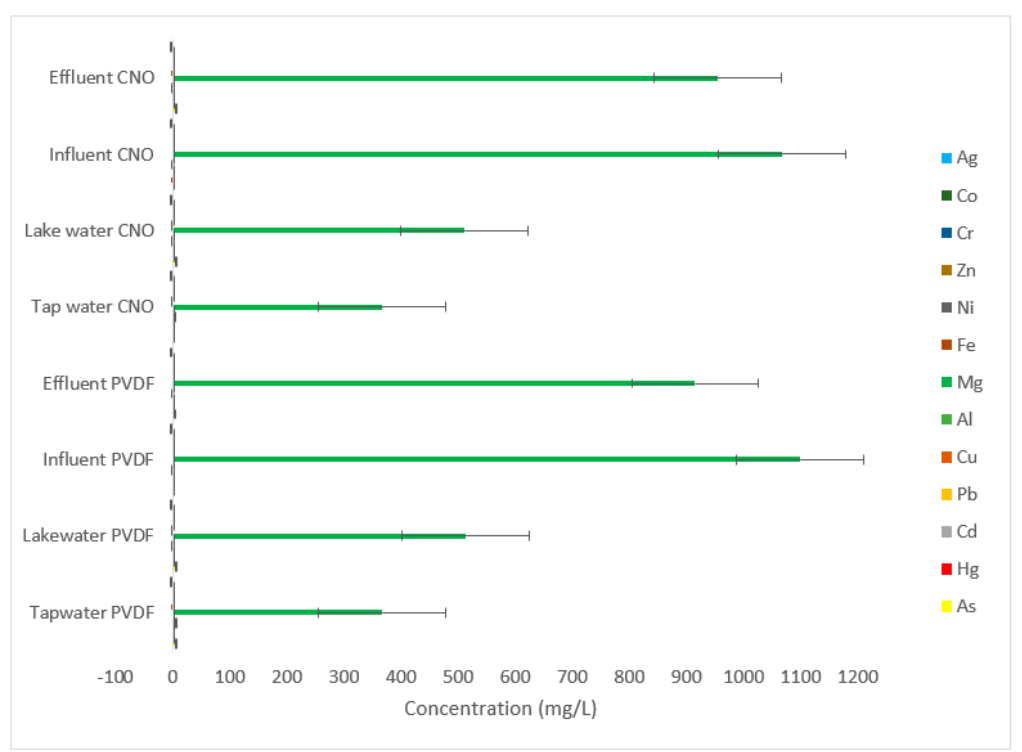
Figure 8. Concentrations of heavy metals from the filtrates of effluent, influent, tap water, and lake water using ICP-OES.